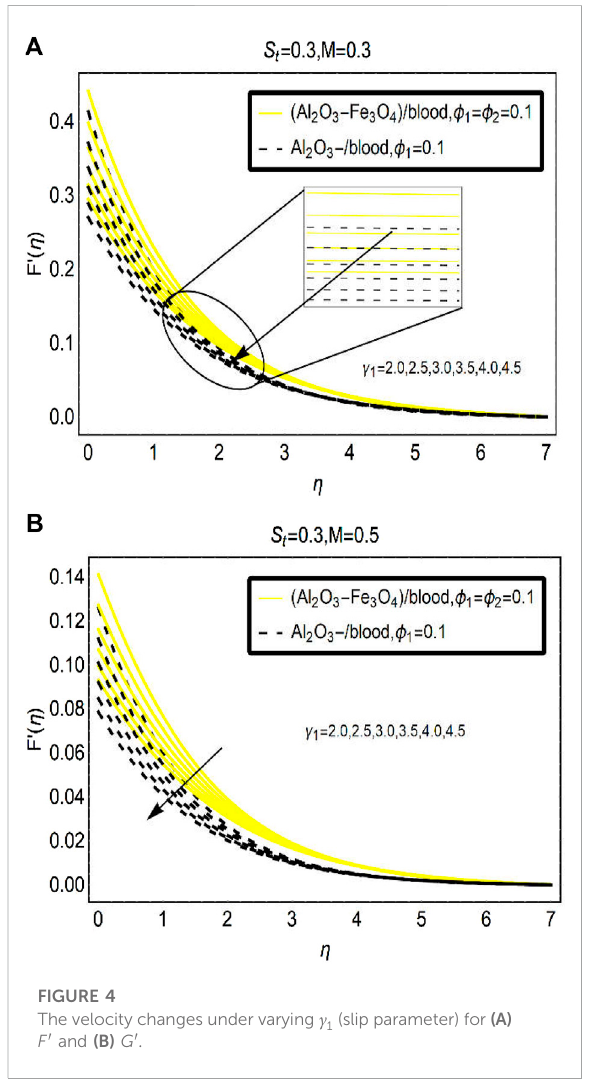
The velocity changes under varying γ 1 (slip parameter) for (A) F ′ and (B) G ′